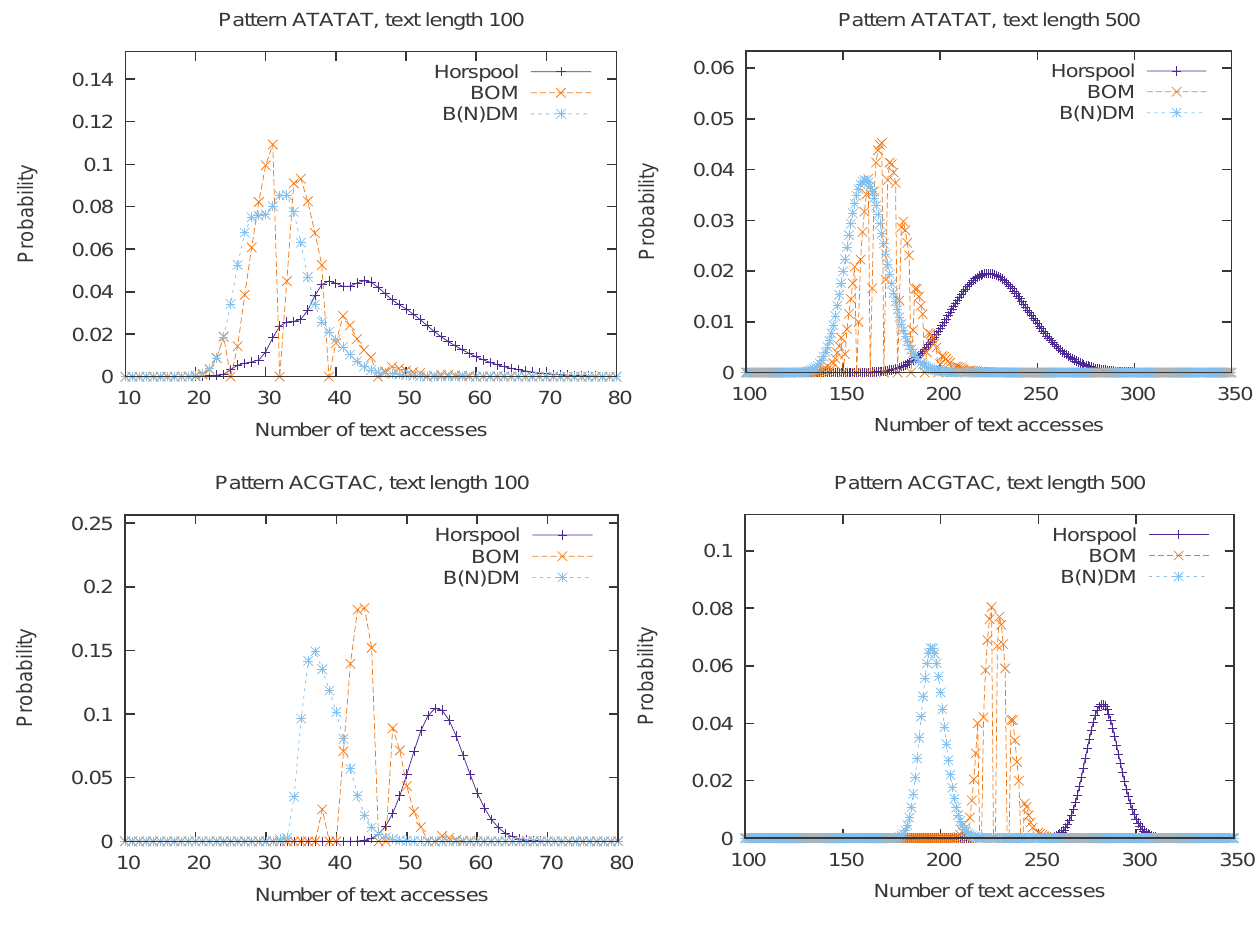
Figure 3. Exact distributions of character access counts for patterns ATATAT (top) and ACGTAC (bottom) for text length 100 (left) and text length 500 (right). A second order Markovian text model estimated from the human genome is